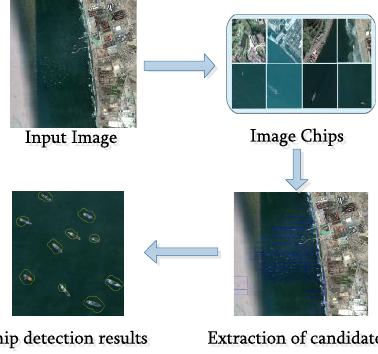
Figure 1. The work flow structure